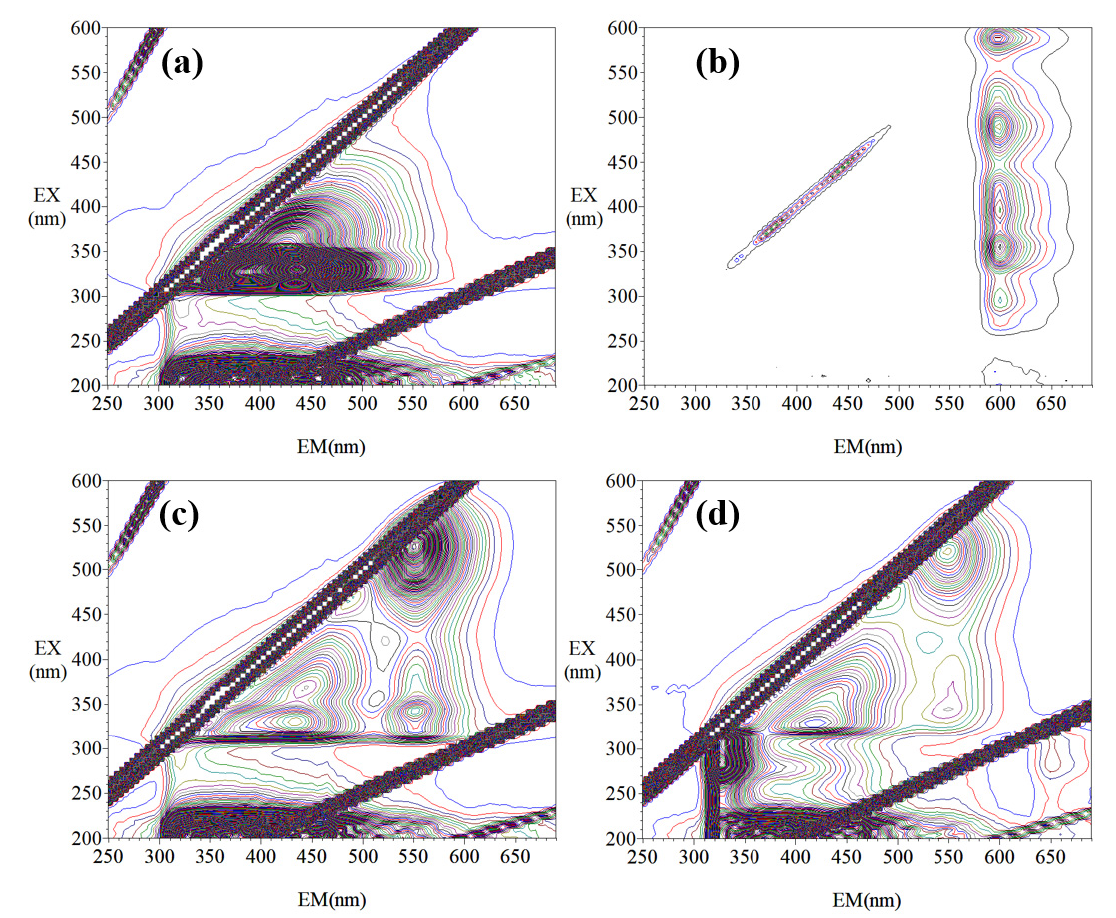
Figure 5. ( a ) Three-dimensional fluorescence spectrum of MOF-5; ( b ) 3-D fluorescence spectrum of RhB; ( c ) 3-D fluorescence spectrum of RhB@MOF-5; and ( d ) 3-D fluorescence spectrum of RhB@MOF-5 response to pork